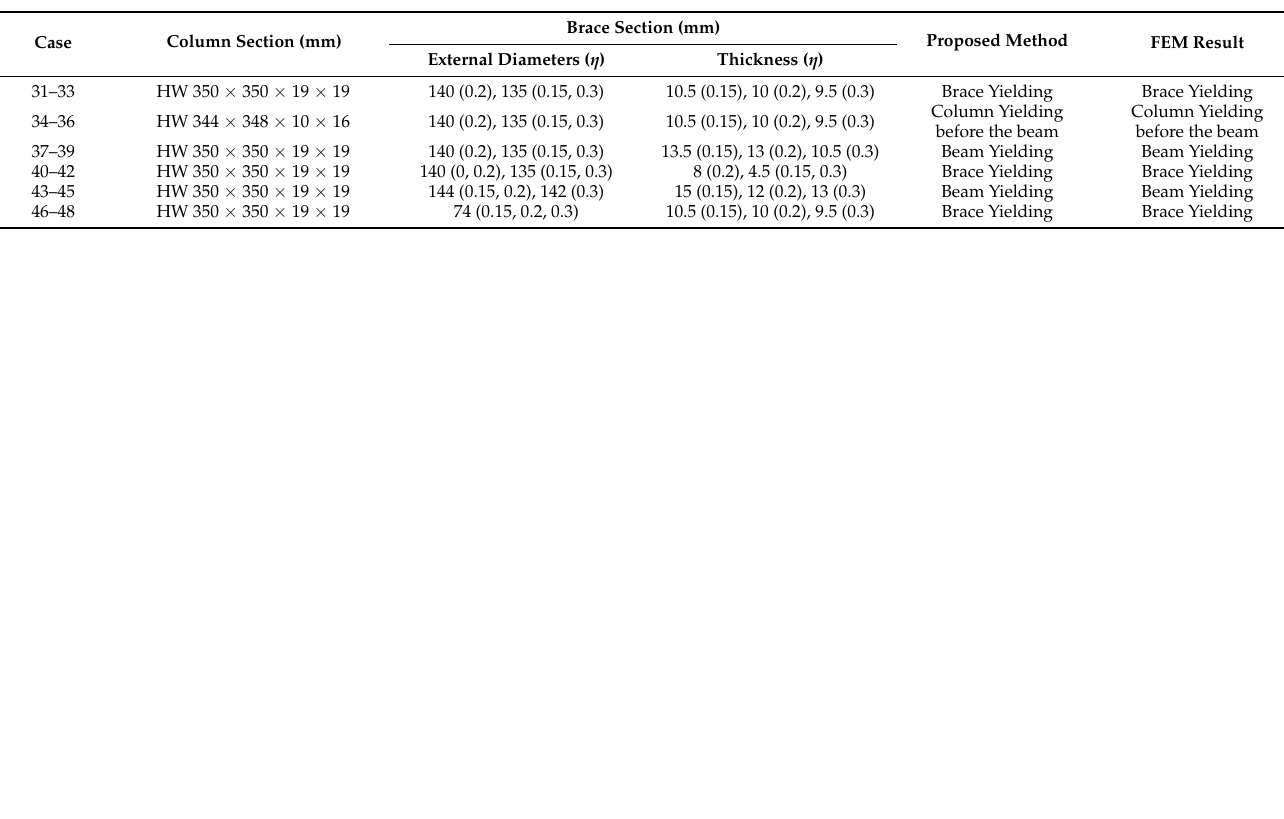
Table A2. Finite element verification results (typical floor, η =0.15,0.2 and